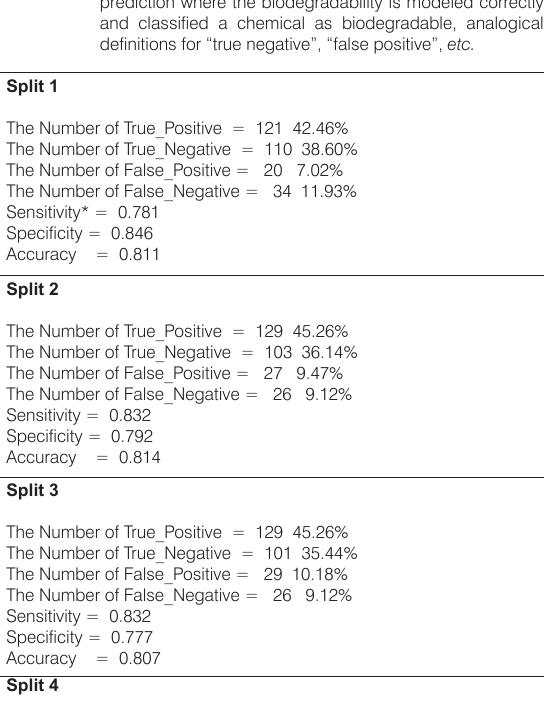
Table 3 contains sensitivity, specificity and accuracy values for the validation set.